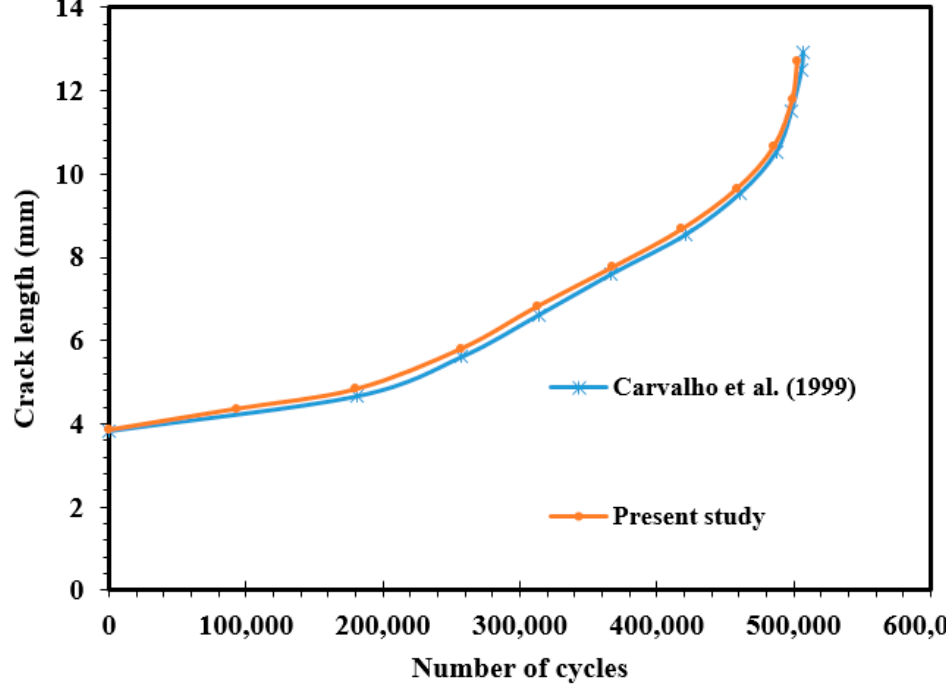
Figure 12. Predicted crack growth path for case I of the PMMA specimen.